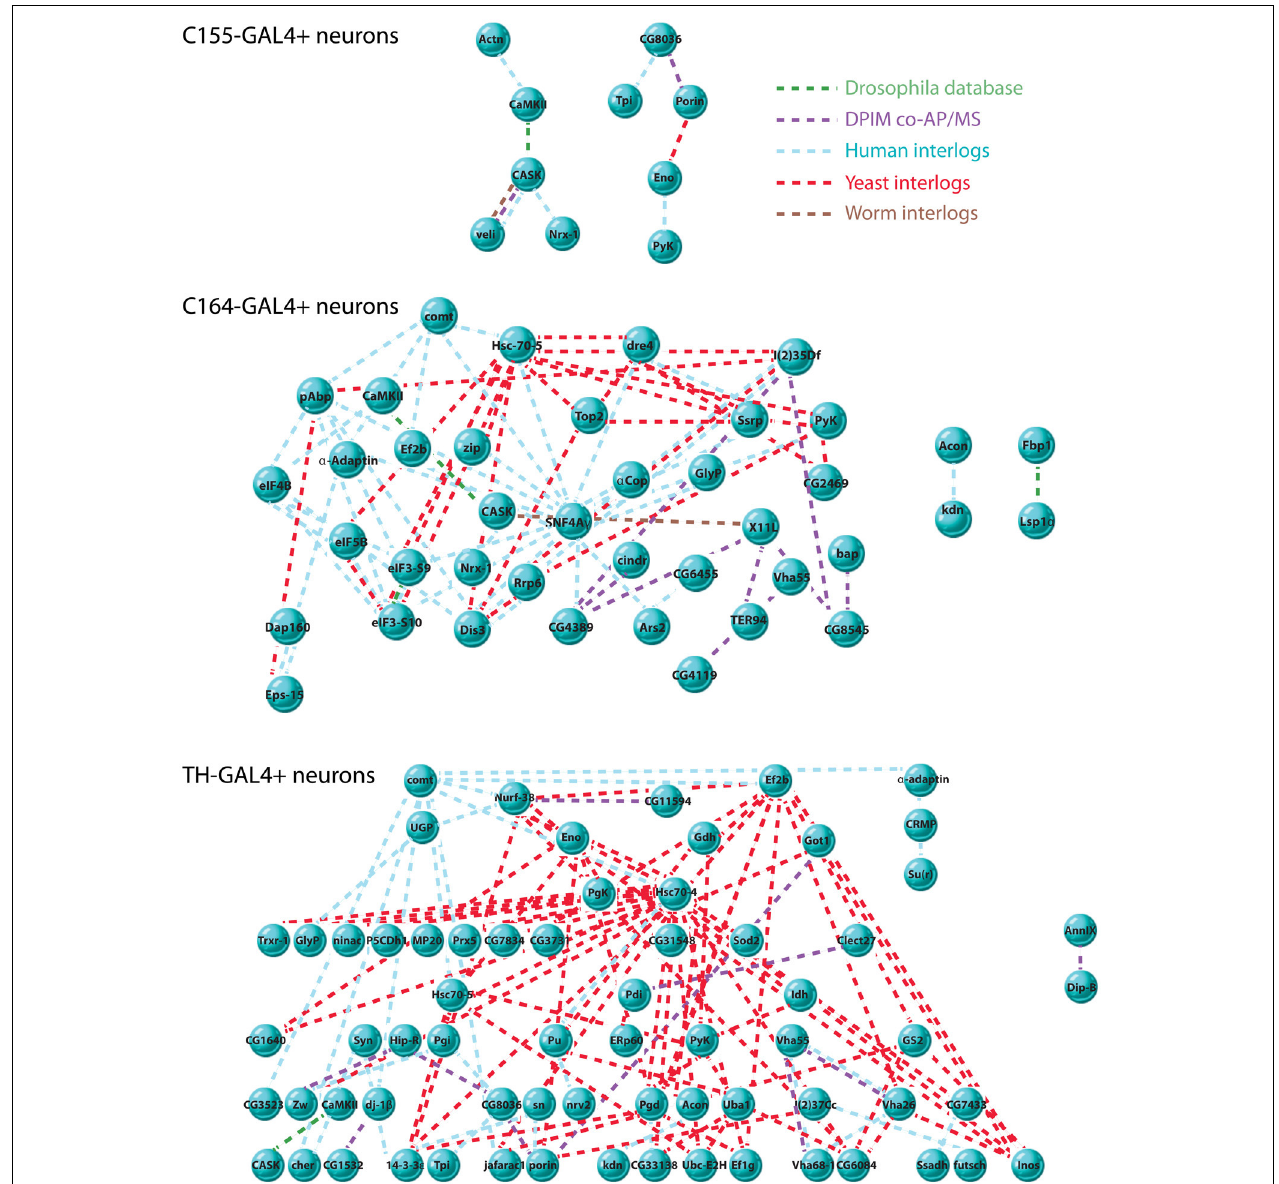
FIGURE 3 | Interaction networks of CASK-associated proteins. Interaction networks were detected using DroPNet (Renaud et al., 2012), a web-based interface for building networks. Proteins found in each cell type were loaded into DroPNet and searched against Drosophila , Yeast, Human, and Worm protein interaction databases. Origin of each interaction is color-coded: Drosophila databases, green, Drosophila Protein Interaction Mapping project, purple, Human interlogs, blue, Yeast interlogs, red, and Worm interlogs, brown. Top: there were 10 interactions in the C155-GAL4 data set (23 proteins), describing 2 networks. 13 members of the data set showed no